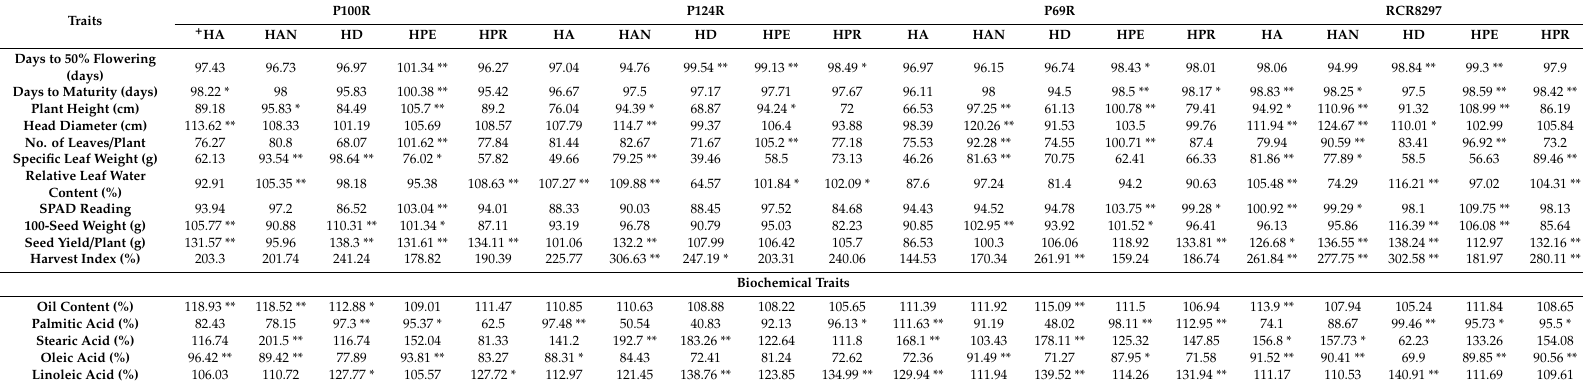
Table 6. Heterosis over commercial check values (%) among CMS sources representing five di ff erent species of sunflower for morphophysiological, yield, and biochemical traits under water stress